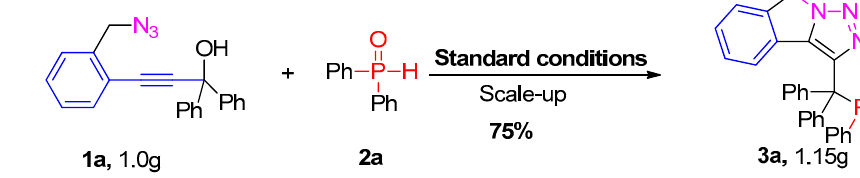
Scheme 2. Scale-up experiment. Scheme 2. Scale-up